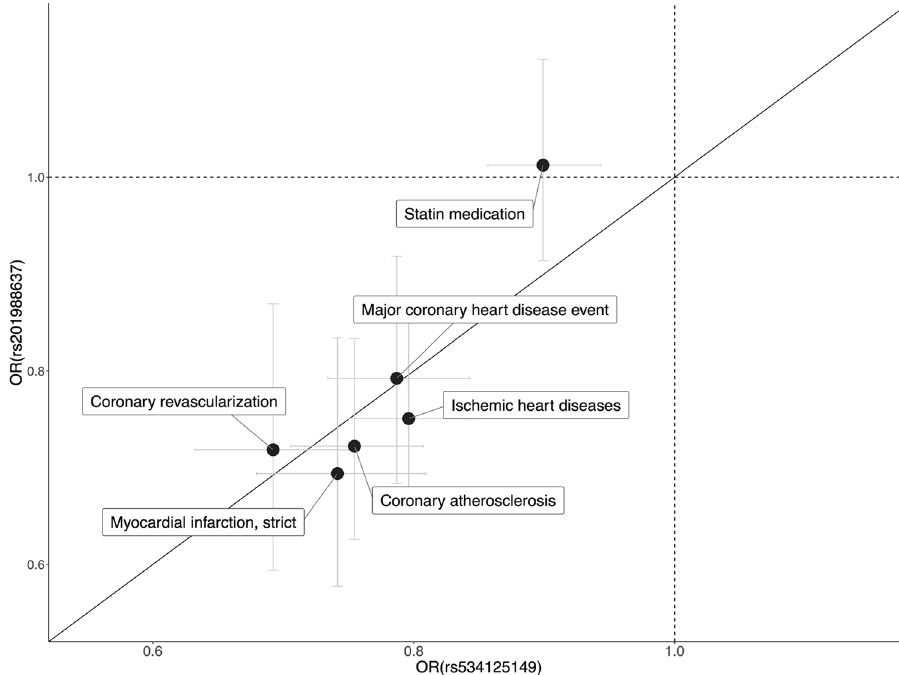
Fig. 5 Effect size comparison. Comparison of the effects (OR) of rs534125149 and rs201988637 for 14 endpoints with p -value < 1.75 × 10 -5 (PWS) for rs534125149 in FinnGen R6. 95% con fi dence intervals represented as gray lines.